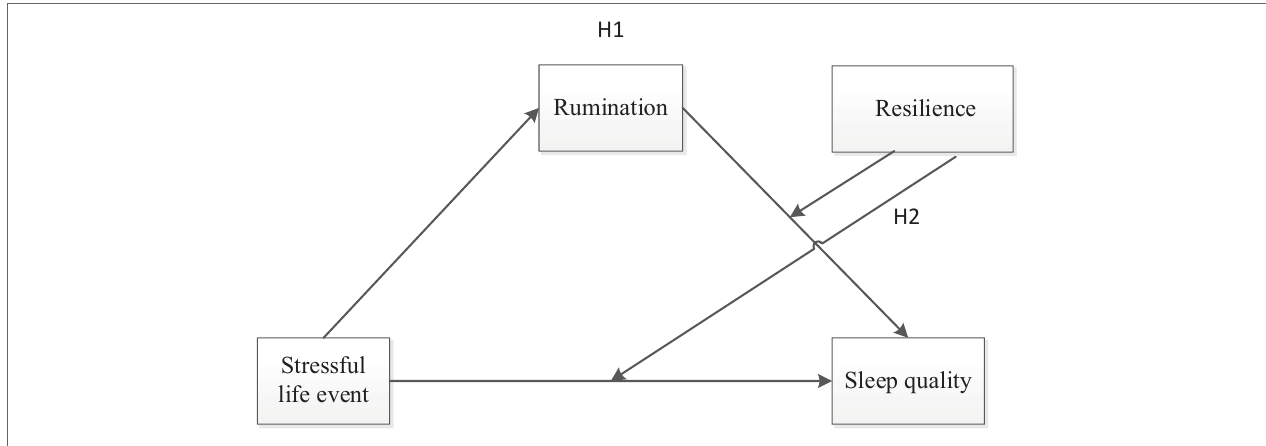
FIGURE 1 | Conceptual